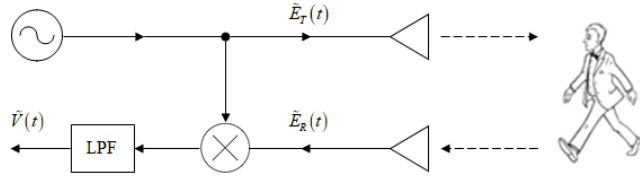
Figure 1. Continuous wave (CW) micro-Doppler